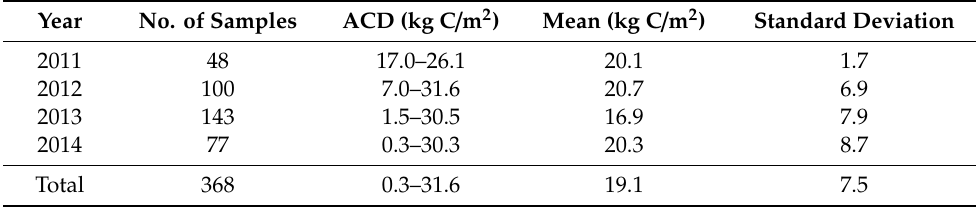
Table 2. Statistics of the collected aboveground carbon density (ACD) samples from di ff erent years. Note: the ACD was calculated based on sample plot size of 500 × 500 m, the same cell size as MODIS.